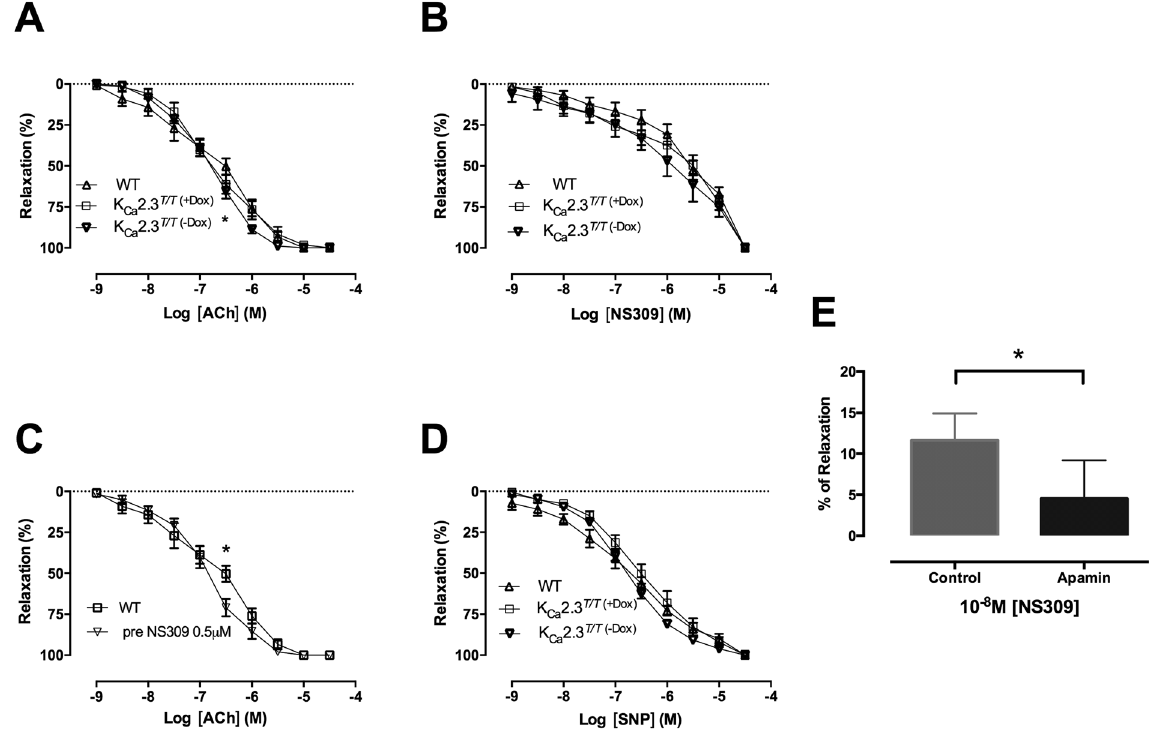
Figure 6. Concentration–response curves for different relaxant compounds (0.001–30 μ M) dependent on nitric oxide and K Ca 2.3 opening in the corpus cavernosum from wild type (WT), K Ca 2.3 T/T ( − Dox) (overexpressed model) or K Ca 2.3 T/T ( + Dox) (down-regulated model) in the corpus cavernosum. ( A ) Concentration-response curves for acetylcholine within the K Ca 2.3 mouse model, (n = 6–9). ( B ) Concentration-response curves for NS309 within the K Ca 2.3 mouse model, (n = 6–9). ( C ) Concentration-response curves for acetylcholine with and without pre-stimulation with 0.5 μ M NS309 in WT mice, (n = 6). ( D ) Concentration-response curves for sodium nitroprusside within the K Ca 2.3 mouse model. ( E ) Single concentration administration of 0.01 μ M NS309 with and without apamin 0.5 μ M in WT mice, (n = 6). Results are means ± S.E.M. P ≤ 0.05 ( * ), (n = 6–9), Student’s t-test or two-way ANOVA followed by Tukey post hoc